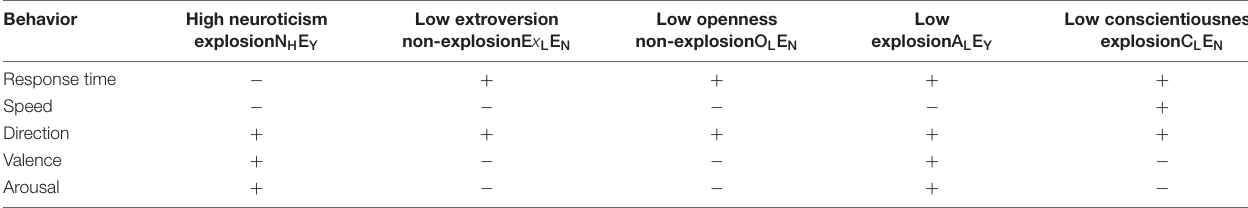
TABLE 14 | Interaction effects of personality dimensions and explosion experiments on individual emotional impact and escape behavior.